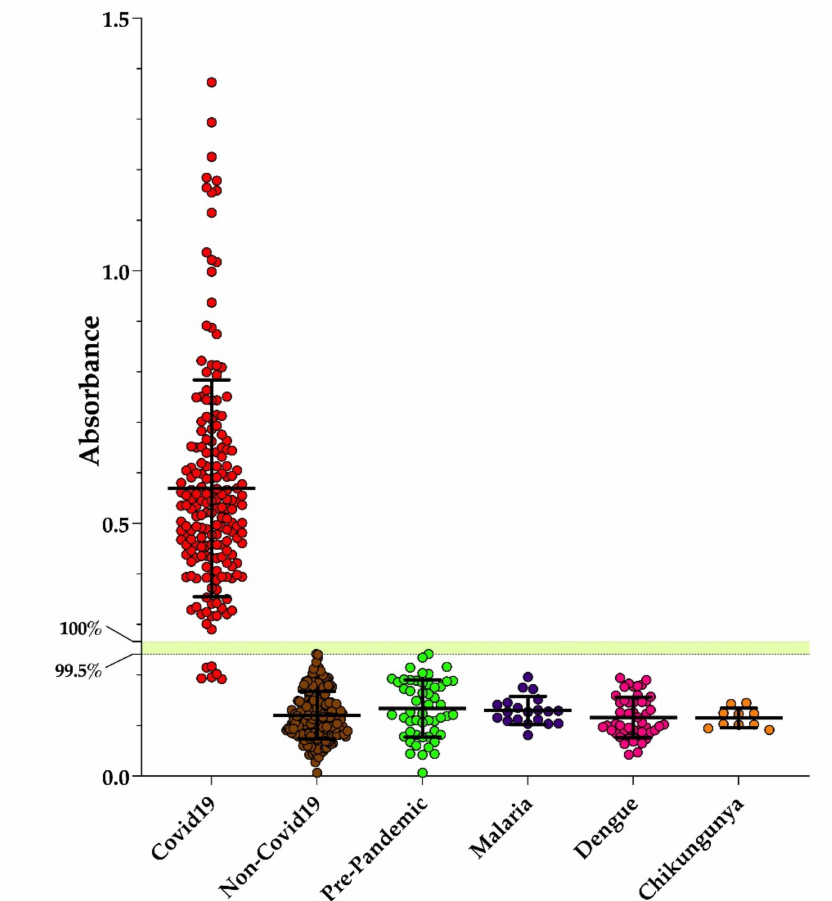
Figure 2. Performance of Dx-SARS2-RBD as a target in an ELISA. ELISA plates were prepared overnight with 200 ng of purified Dx-SARS2-RBD protein before performing an immunoassay to detect human IgG in sera collected from patients confirmed with COVID-19 ( n = 185). Controls included non-COVID-19 patients ( n = 205) and sera collected before the start of the pandemic from healthy individuals (pre-pandemic, n = 51) as well as patients diagnosed with malaria ( n = 20) dengue ( n = 48), and chikungunya ( n = 10). The median with the SD is shown. The two cutoffs were determined from ROC